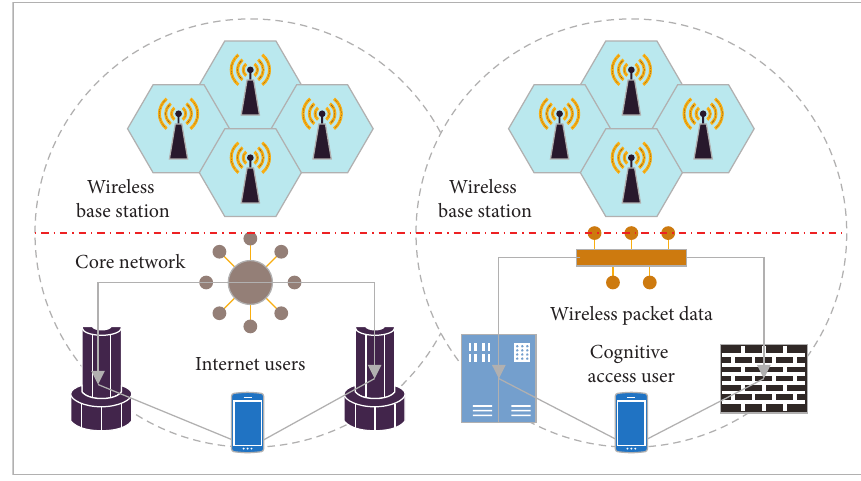
Figure 1: Wireless communication network architecture. Table 1: Transmission path of wireless body area